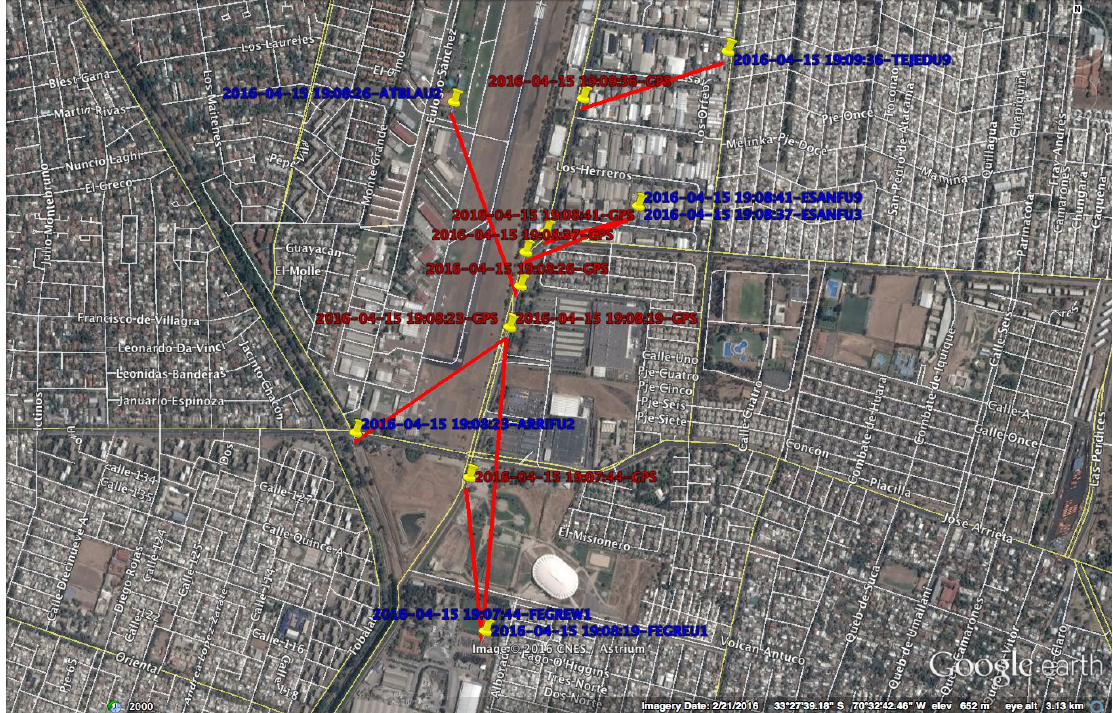
Figure 9. GPS tracking to measure the difference between the device location (red labels) and the antenna location (blue labels). In this image the antennas are located in the position of the corresponding